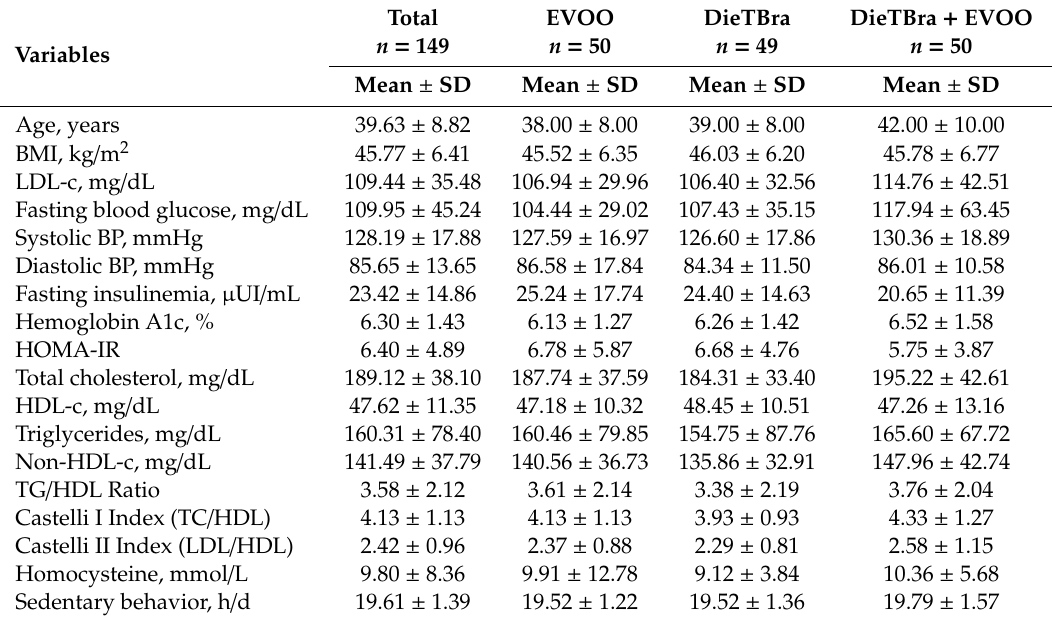
Table 1. Baseline characteristics according to randomization